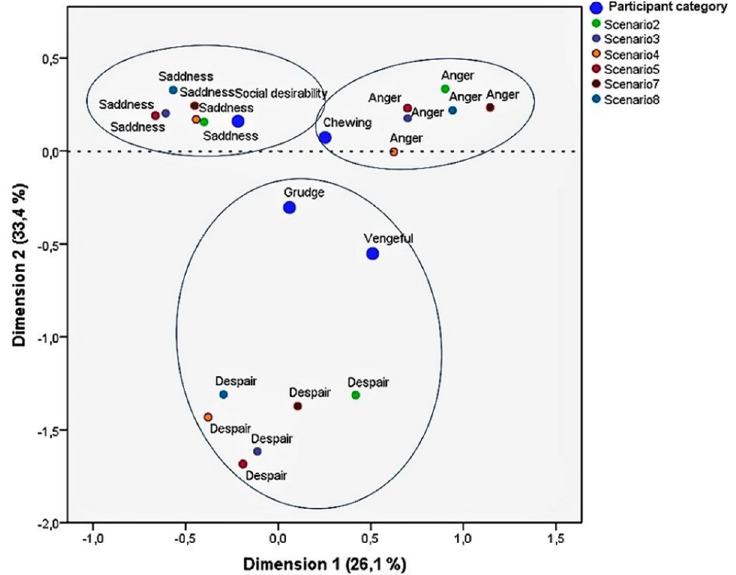
Figure 6. Multiple correspondence analysis map: ARS_13 and the PEI emotional scale.